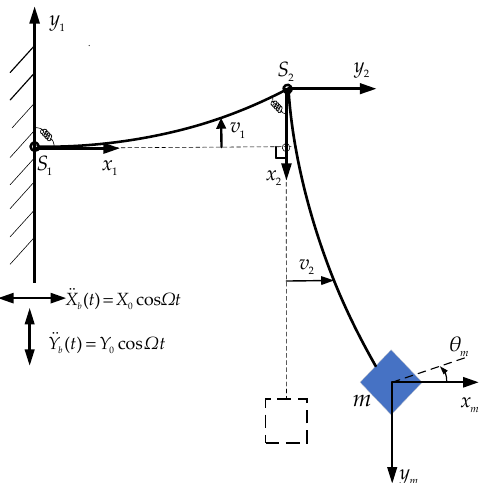
Figure 1. Schematic of L-shaped multi-beam structure.